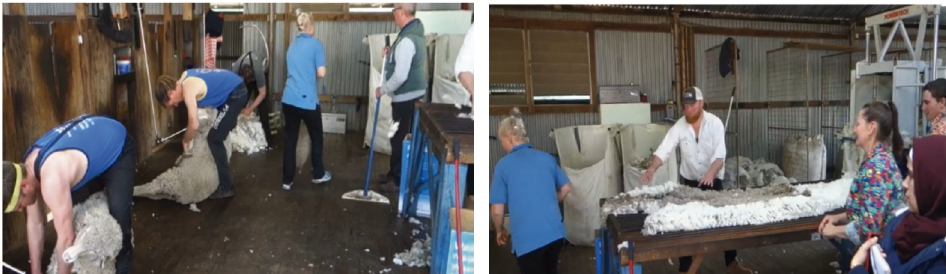
Figure 4. Shearing stage (left) and skirting stage